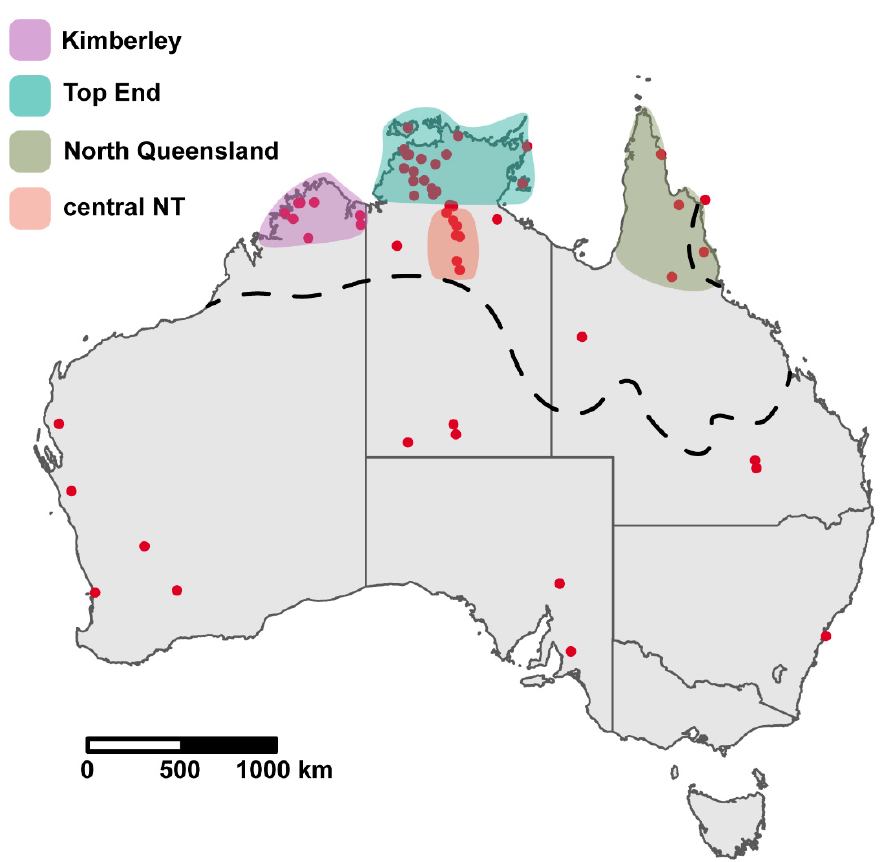
Figure 1. Map of Australia showing the approximate boundary of the monsoonal tropics (dashed line), where rainfall is very heavily concentrated in a summer wet season. Collection localities (red dots) for sequenced specimens of the Monomorium nigrius group are indicated, as are the four regions in the monsoonal zone where collections are concentrated.